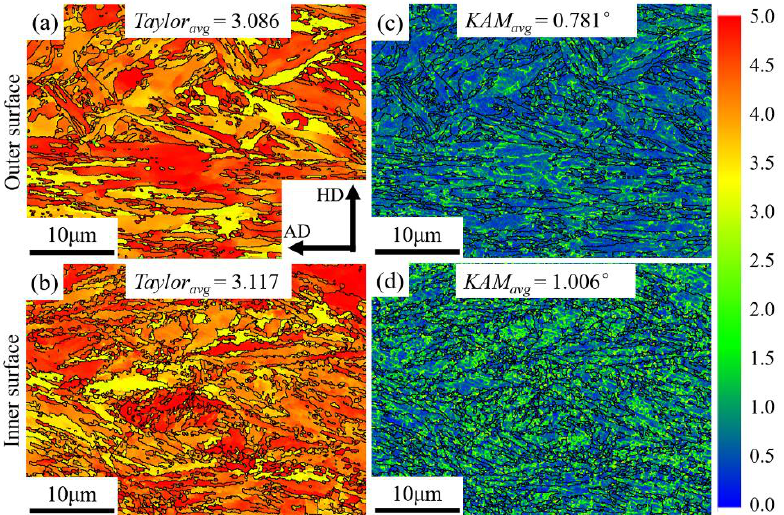
Table 7. The average Taylor factor of the forged tube with a reduction of 42.7%.